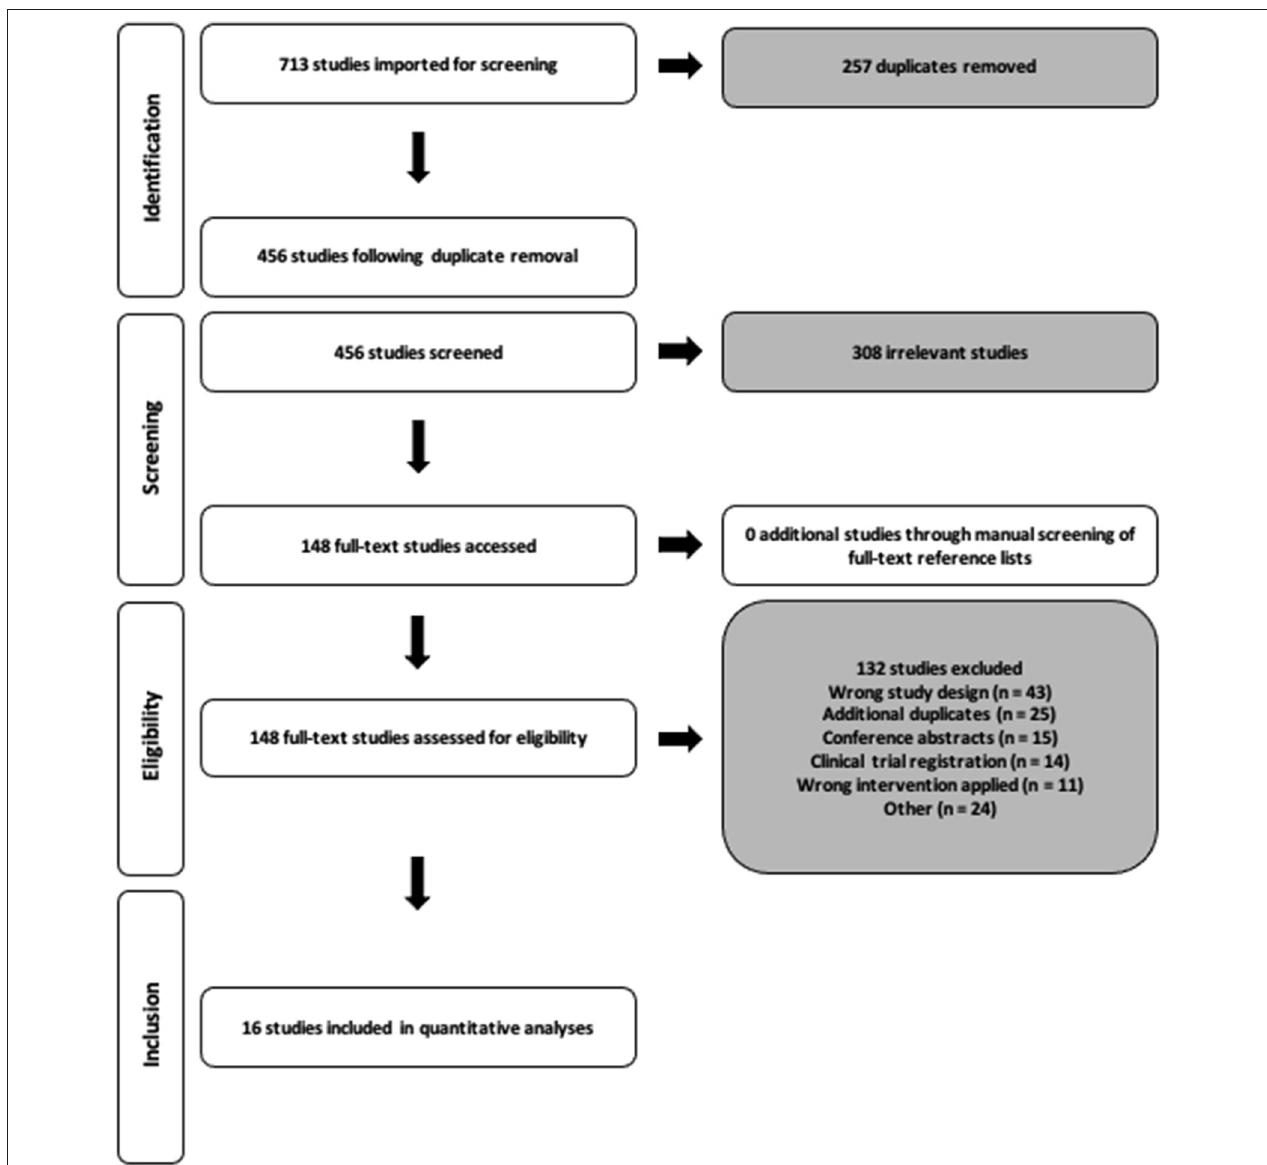
FIGURE 1 | PRISMA study selection flow